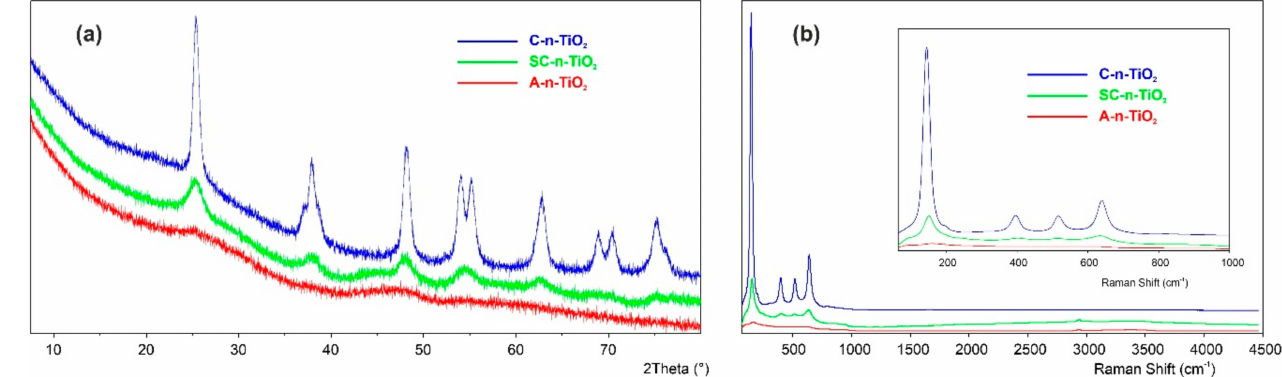
Figure 1. XRD ( a ) and Raman ( b ) characteristics of synthesized n-TiO 2 materials.